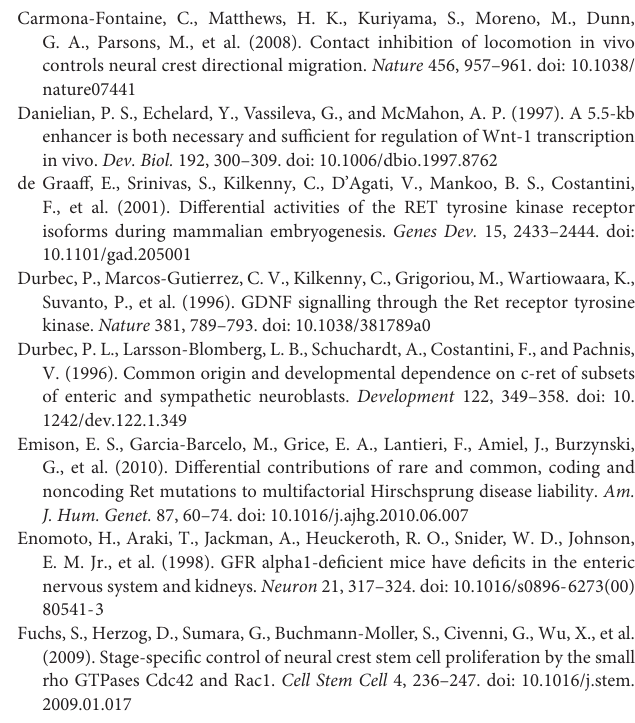
Supplementary Figure 1 | Short term cultures of dissociated guts from control Tg Ret + / 51 and Tg Ret 51 / 51 embryos were immunostained for different markers. Graph shows the quantification of percentage of GFP cells co-expressing TuJI at E11.5 in Tg Ret + / 51 control (green box) and Tg Ret 51 / 51 (red box) embryos n = 6. This was similar to the neuronal marker HuC/D where a significantly smaller fraction of Tg Ret 51 / 51 GFP + cells have differentiated into neurons. Quantification of GFP cells co-expressing either GFAP ( n = 4) or Sox10 ( n = 4) in E14.5 control Tg Ret + / 51 versus mutant Tg Ret 51 / 51 embryos also showed that GFAP expression was similar to B-FABP whereby the percentage was higher in mutant versus control. This is also shown with Sox10 expression which labels both undifferentiated cells as well as glial cells. The fraction of Tg Ret 51 / 51 GFP + cells that have differentiated into neurons is reduced at E11.5 and the fraction expressing glial markers is increased at E14.5. Statistical analysis performed by Welch’s t -test. Tg Ret + / 51 represents cells or embryos from genotype Wnt1 cre / + ;R26R stop / YFP ;Ret + / 51 and Tg Ret 51 / 51 represents cells or embryos from genotype Wnt1 cre / + ;R26R stop / YFP ;Ret 51 / 51 . Supplementary Figure 2 | Reduced neuronal differentiation in Ret 51 / 51 EPC from postnatal gut myenteric peels. EPCs cultured after transduction of P1 control ( Ret + / + ) or Ret 51 / 51 guts using a GFP retrovirus, and labelled with GFP (green) to mark all infected cells and TuJ1 (red), a pan neuronal marker to label all neurons. (A) Colony from control ( Ret + / + ) EPC showed normal neuronal differentiation. (B) Colony from Ret 51 / 51 EPC showed reduced neuronal differentiation. (C) Quantification of neuronal differentiation in colonies. n = 3 for each genotype. Statistical analysis performed by Welch’s t